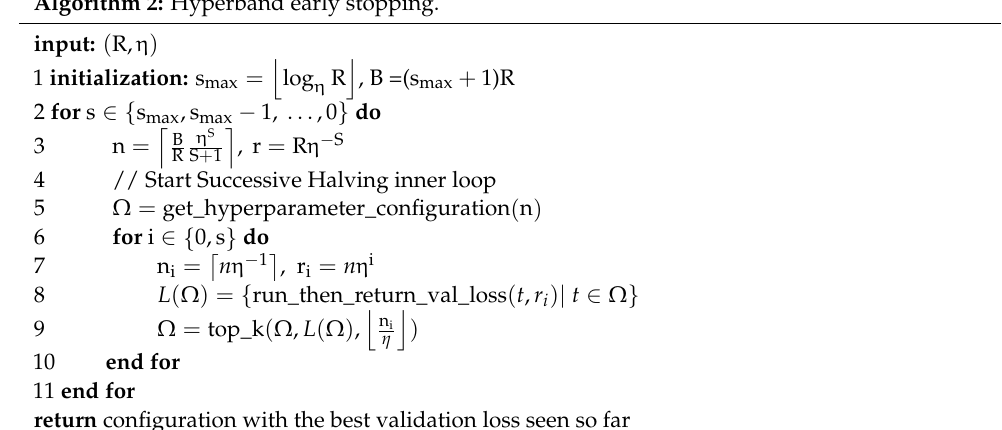
Algorithm 2: Hyperband early